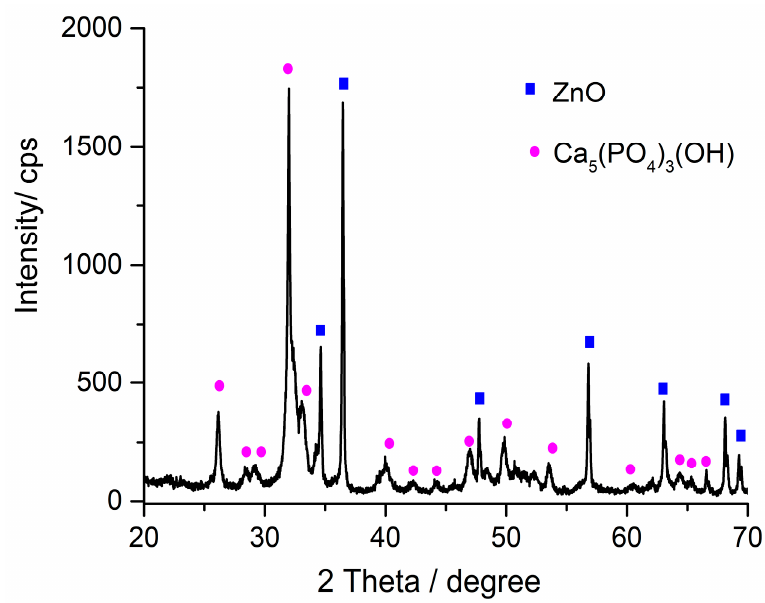
Figure 1. XRD pattern of the ZH powder.